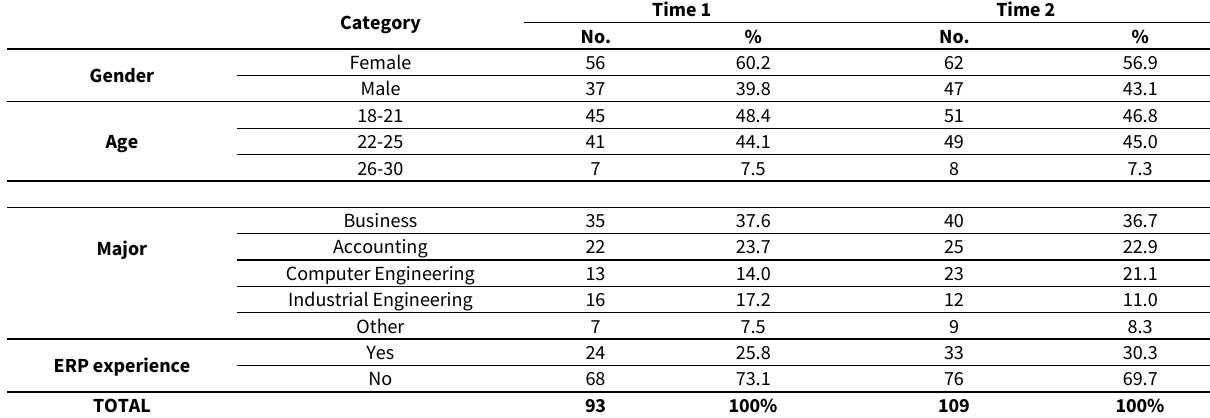
Table 3. Student demographic information – Time 1 and